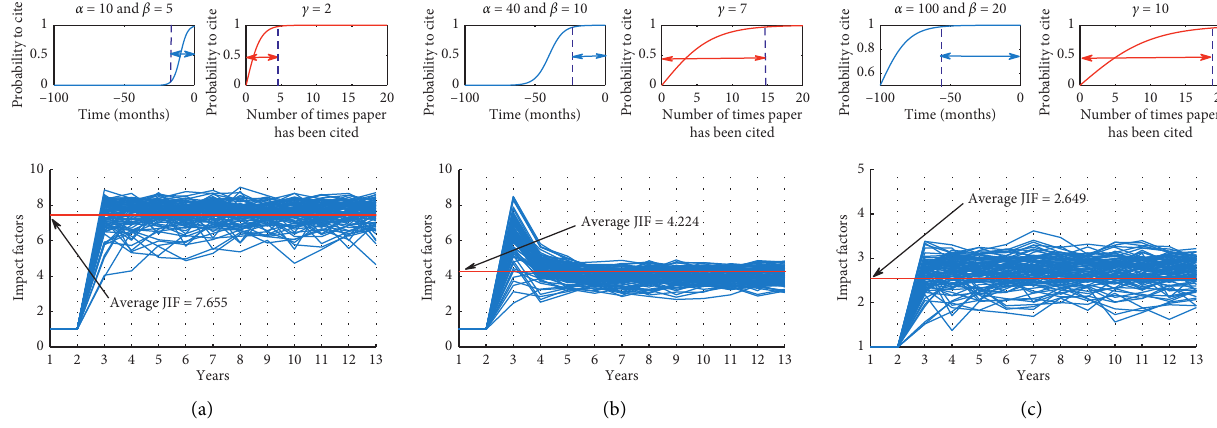
Figure 12: Variation of the JIF within 13 years in 100 Monte Carlo simulations with T